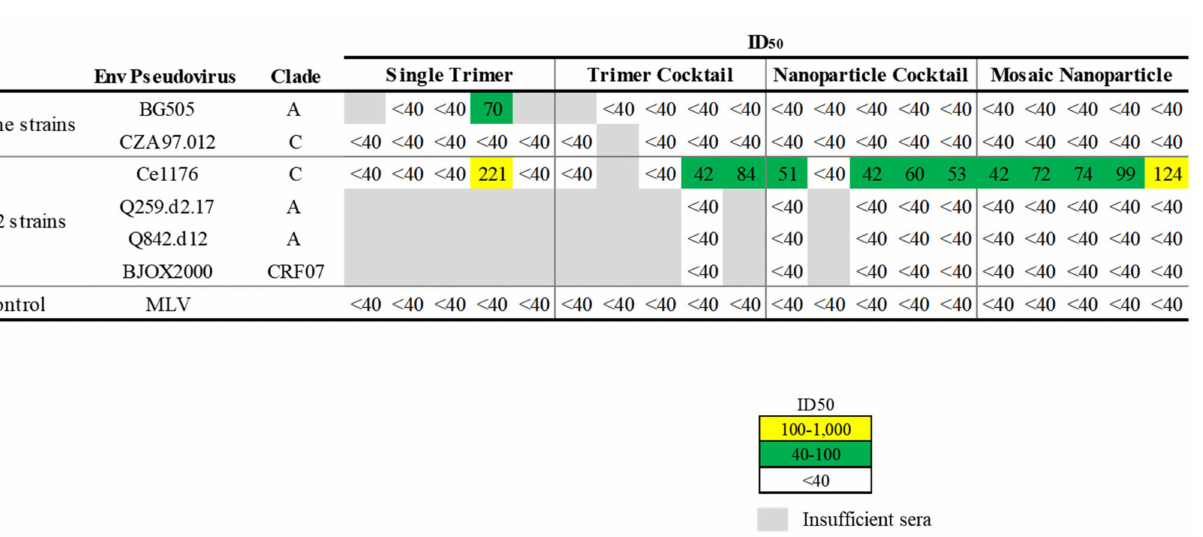
Figure 3. Nanoparticle immunogens elicit neutralizing antibody responses in mice. Plasma samples collected from mice ( n = 20) immunized with BG505 trimer, a cocktail of BG505 and CZA97 trimers, single—antigen nanoparticle cocktail, or mosaic nanoparticles were tested for neutralization to vaccine—matched and Tier 2 pseudoviruses. Mouse sera neutraliza- tion titers were reported as serum dilution required to inhibit 50% of virus infection (ID 50 ). The magnitude of neutralization responses (ID 50 ) is indicated by the color, from moderate potency (yellow) to lower potency (green) and no activity (white). Gray cells denote insufficient sera for